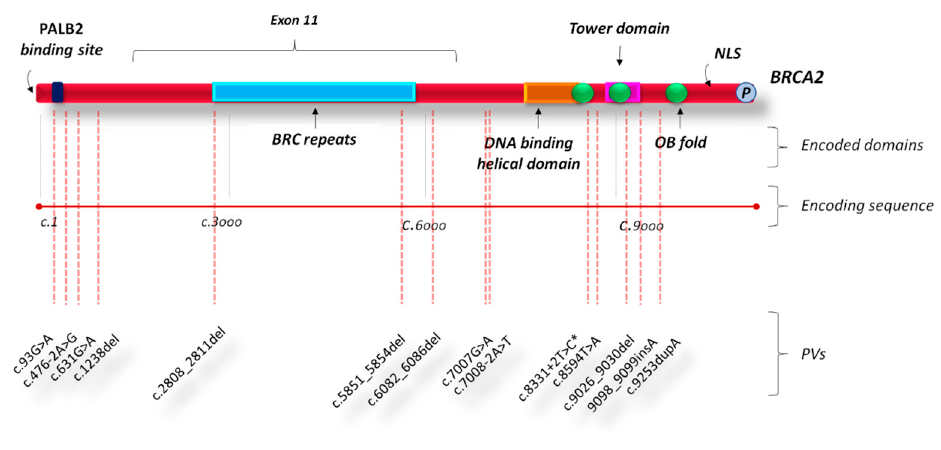
Figure 3. BRCA2 functional domains and gene location of BRCA2 PVs in bilateral breast cancer patients. Abbreviations: NLS, nuclear localization sequence; OB, oligonucleotide binding; PVs, pathogenic variants. * This PV is present together with the BRCA1 PV named c.181T>G in one patient showing double heterozygosity for BRCA1 and BRCA2 PVs.